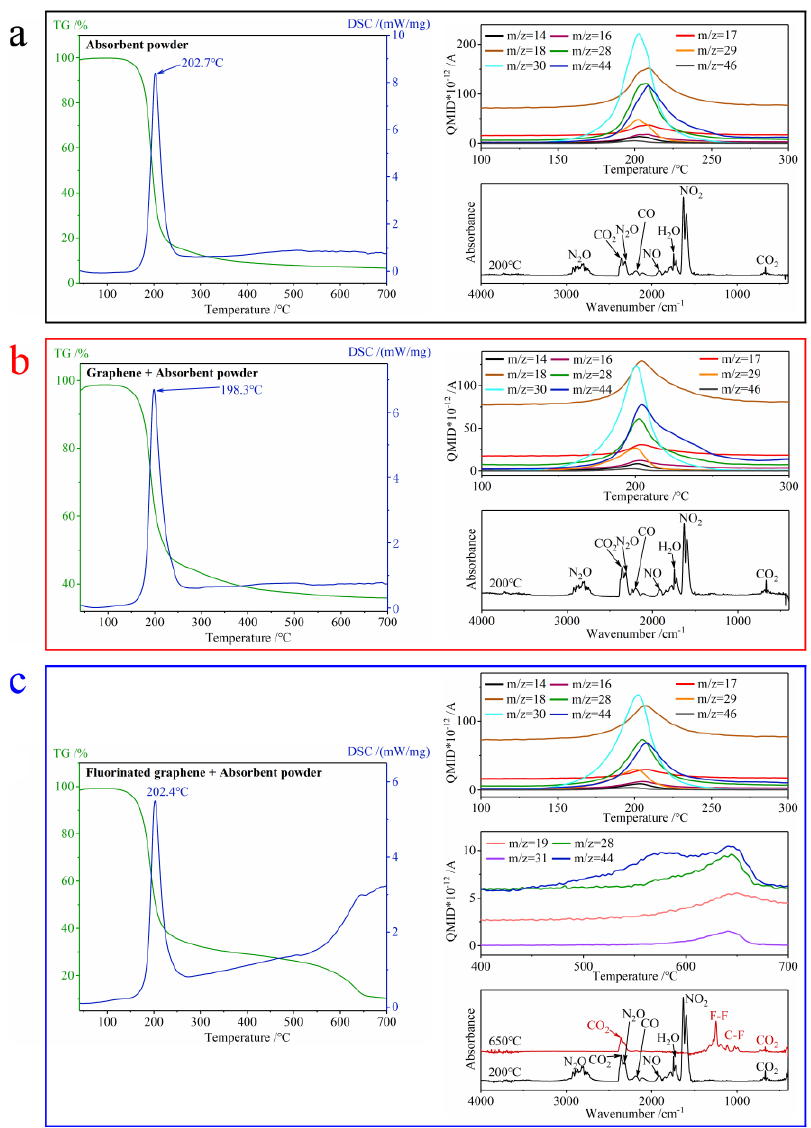
Figure 14. The TG-DSC-MS-FTIR curves of composites under N 2 at 40–700 ◦ C. ( a ) Absorbent powder. ( b ) Graphene + absorbent powder. ( c ) Fluorinated graphene + absorbent